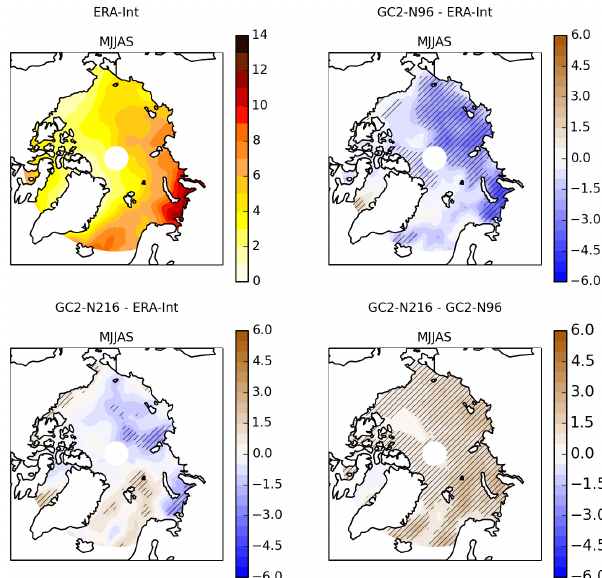
Figure 1. Vorticity-based tracking – multi-annual MJJAS mean cyclone track density (10 − 6 km − 2 month − 1 ): ERA-Interim, GC2- N96 minus ERA-Interim, GC2-N216 minus ERA-Interim and GC2- N216 minus GC2-N96. ERA-Interim uses the 1990–2009 MJJAS mean, while GC2-N96 and GC2-N216 use the MJJAS mean over the last 100 years of the 150-year run. Hatching indicates that the difference is shown by Welch’s t test to be statistically significant at the 95% level.